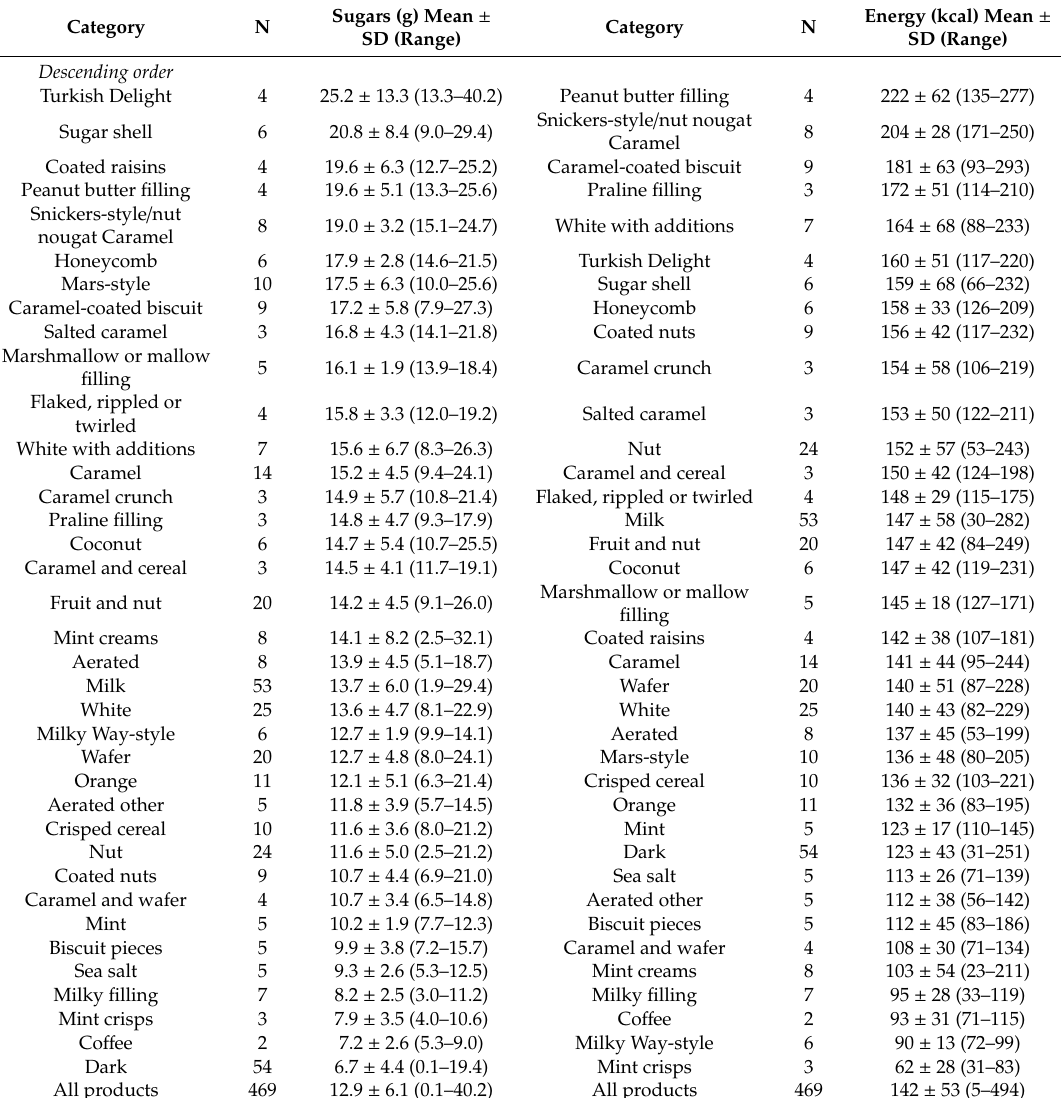
Table 4. Sugar and energy contents in di ff erent categories of chocolate confectionery per serving in